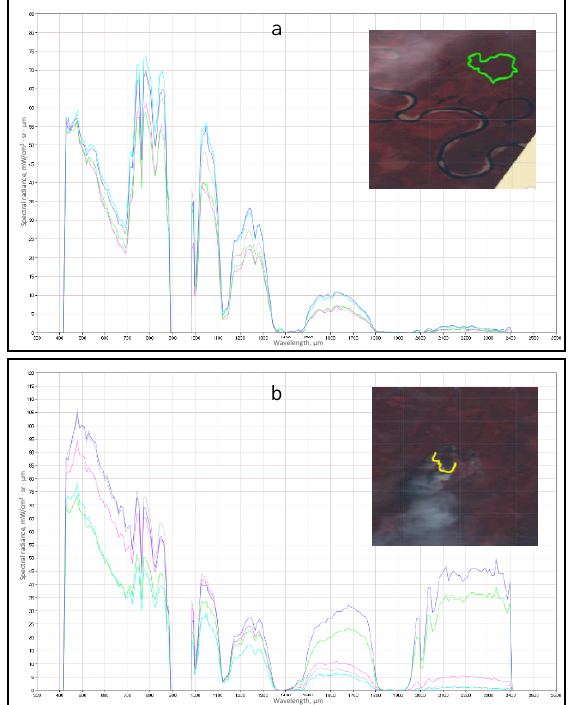
Figure 11. Spectral profiles of controlled forest plots: a) undamaged by forest fire, b) flame front. Hyperion data (08.06.2011, 60 0 46′ N 88 0 59′